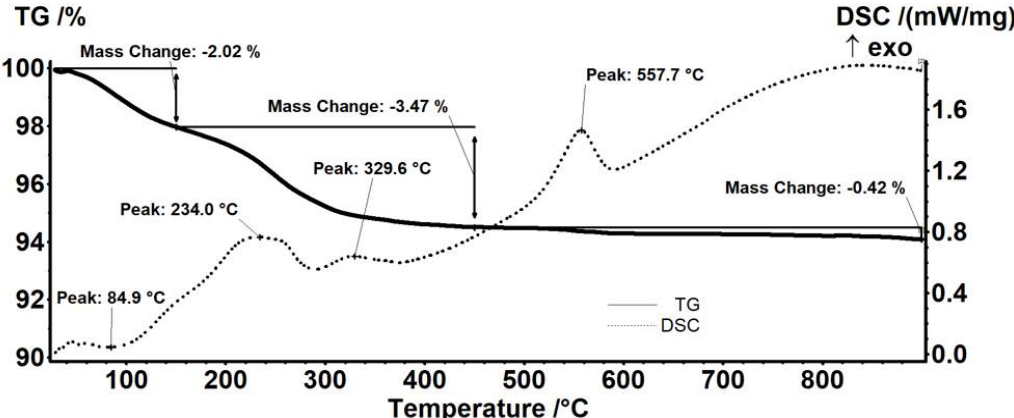
Figure 6. Thermogravimetric analysis of Fe 3 O 4 -STR nanoparticles.